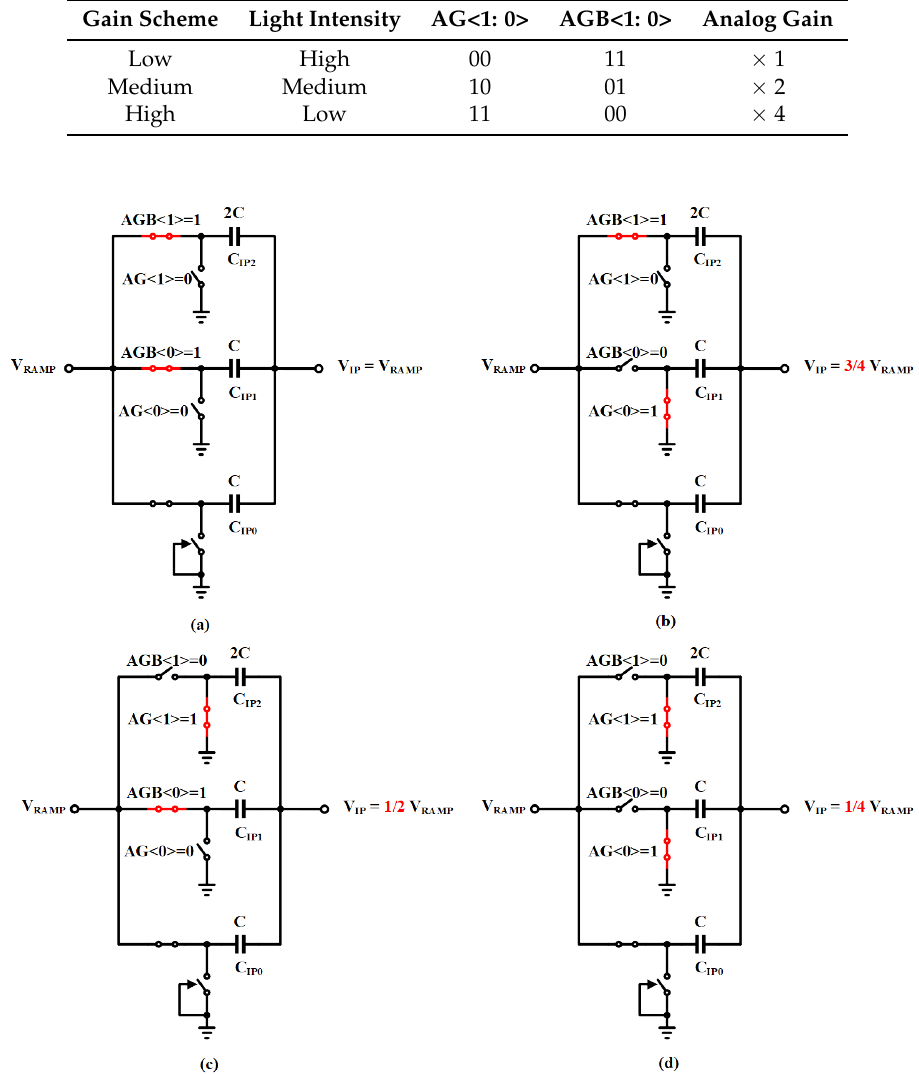
Figure 7. The gain control structure with different control voltages.( a ) AG<1: 0> = 00; ( b ) AG<1: 0> =